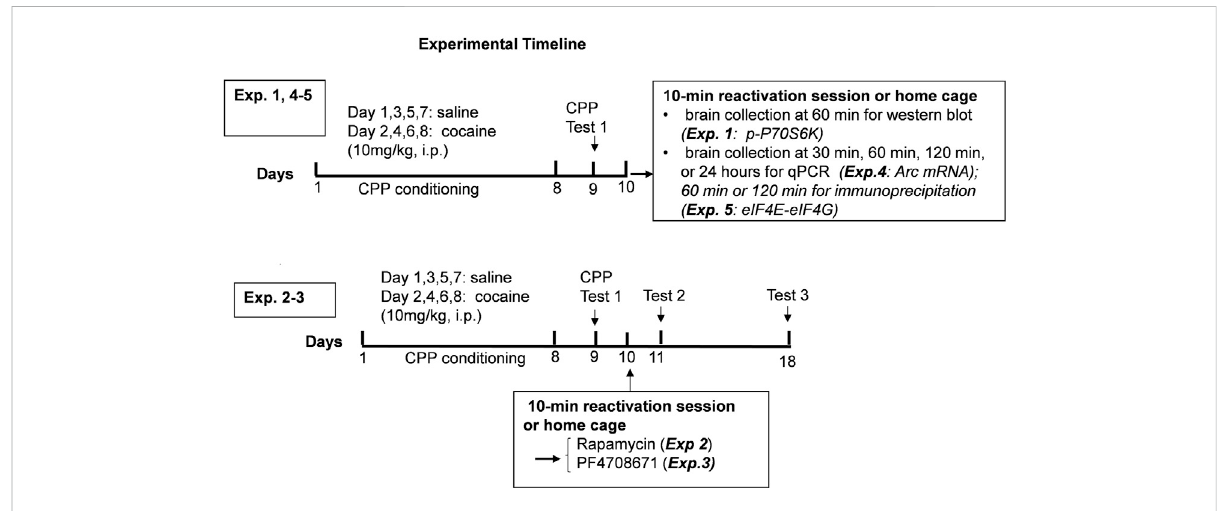
FIGURE 1 Experimental